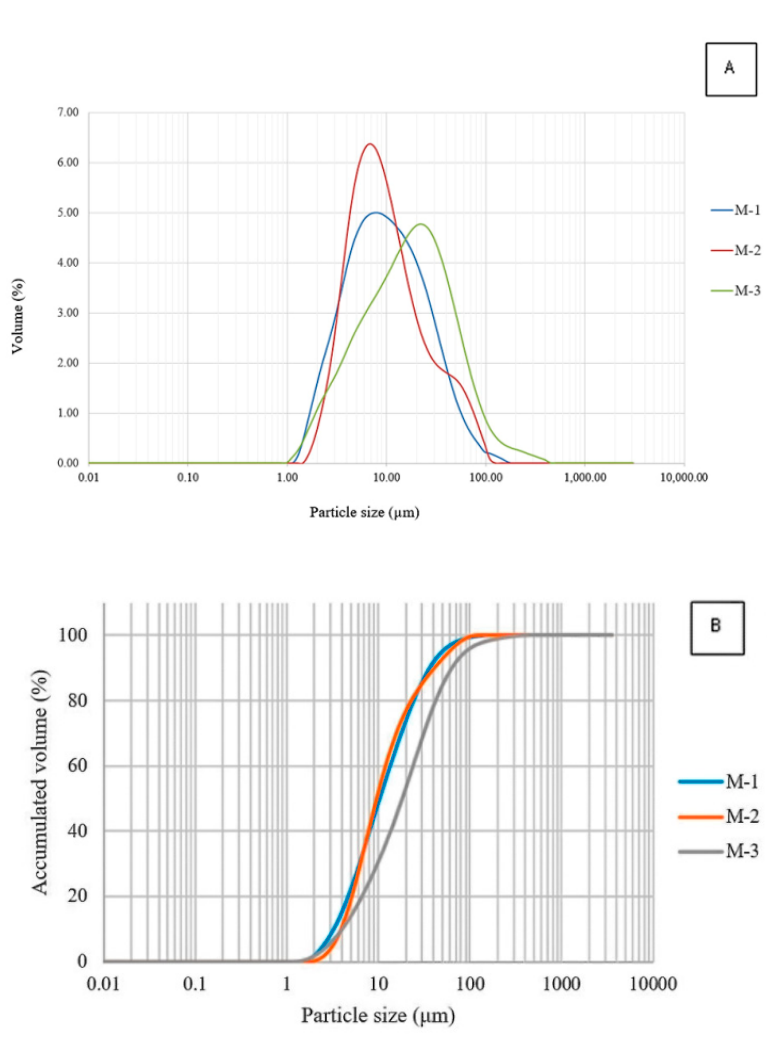
Figure 3. ( A ) The particle-size distributions of samples M-1, M-2 and M-3 and ( B ) the accumulated curves of samples M-1, M-2 and M-3. Table 2. The particle size parameters.